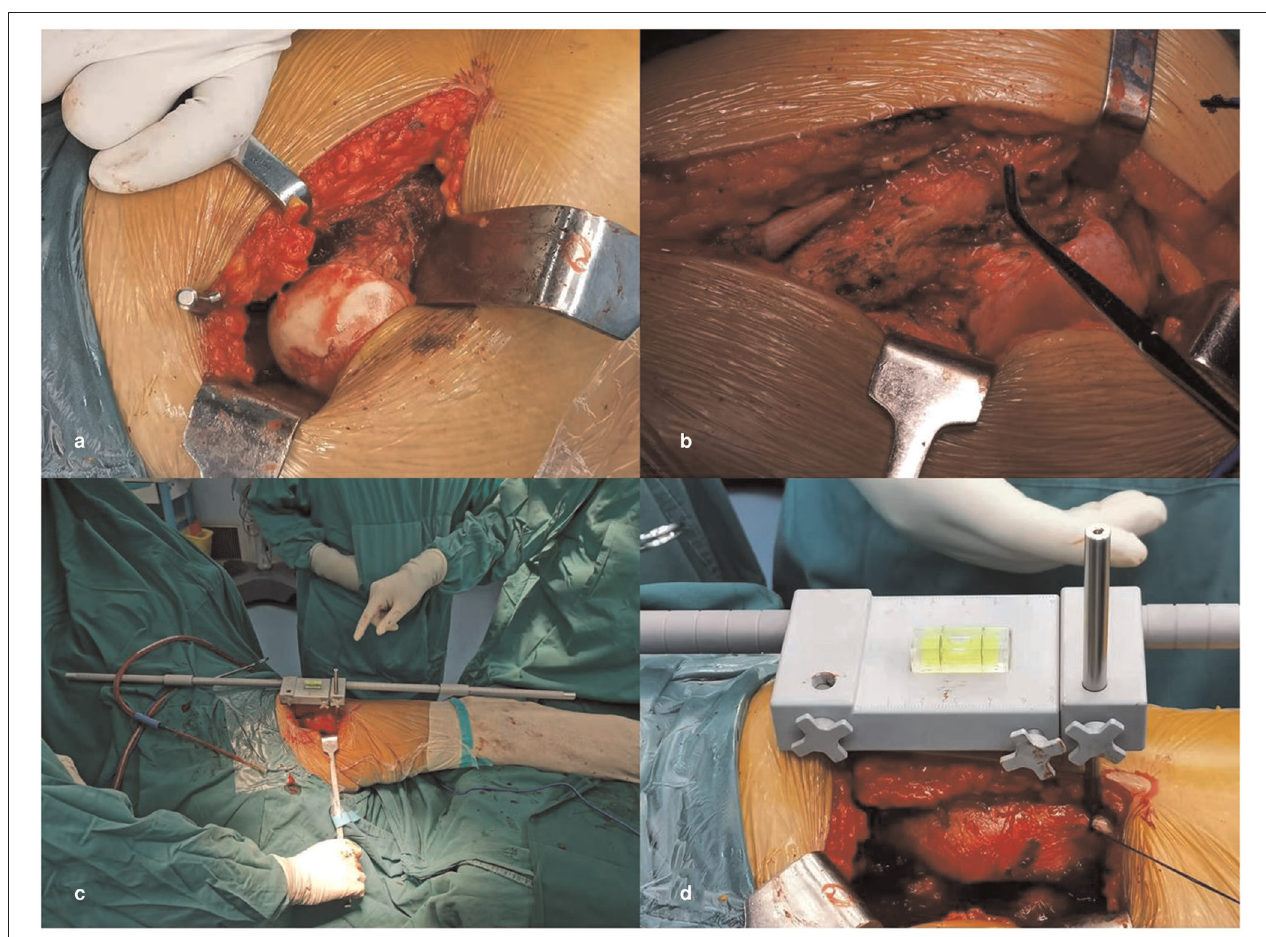
FIGURE 5 | Intraoperative measurement of the horizontal calibrator. A lateral acetabular wire was inserted 3–5cm above the greater trochanter at 1 o ’clock (right hip) or 11 o ’clock (left hip) as a static reference point in (a) . The surgeon looks for a bony projection in the middle of the intertrochanteric spine of the femoral shaft as a reference point in (b) . It was made sure that both lower legs are in the grooves of the double reverse “U” pad. The bubble level and extension rod were adjusted so that the bubble of the level is centered and the extension rod is parallel to the affected limb and the longitudinal axis of the body (c) . The locking screw was fixed sequentially, the values were read and recorded (d) .